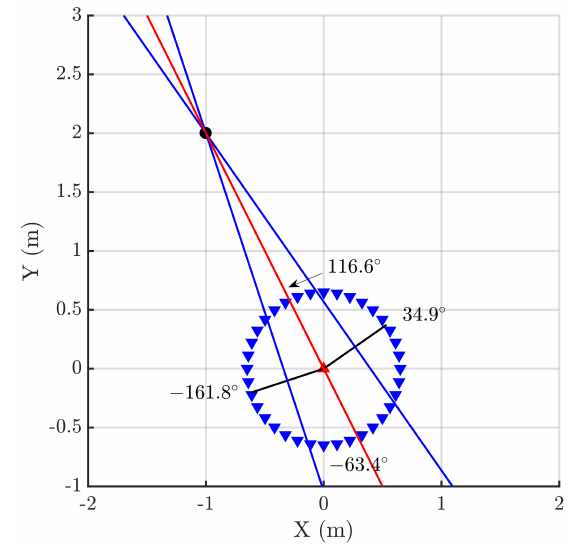
Figure 1. Different positions representative of antenna 2 marked with triangles ( (cid:72) ) when turned around the fixed antenna 1 ( (cid:78)